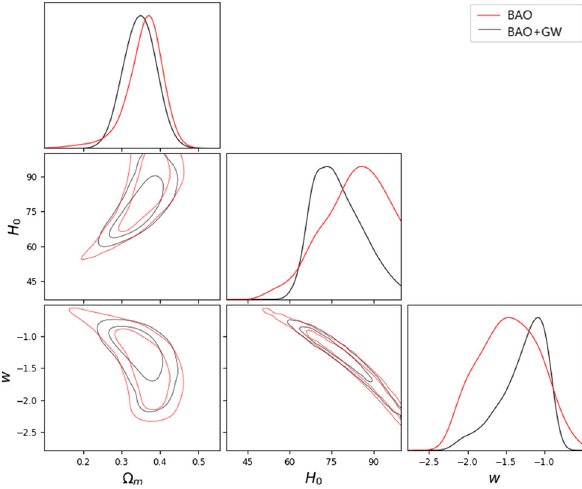
model. In addition, the value of Ω k is consistent with 0 within 68% CL.